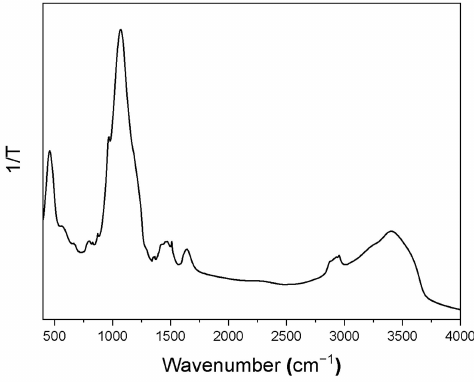
Figure 3. FTIR spectrum of BGl@PcHfCl 2 .